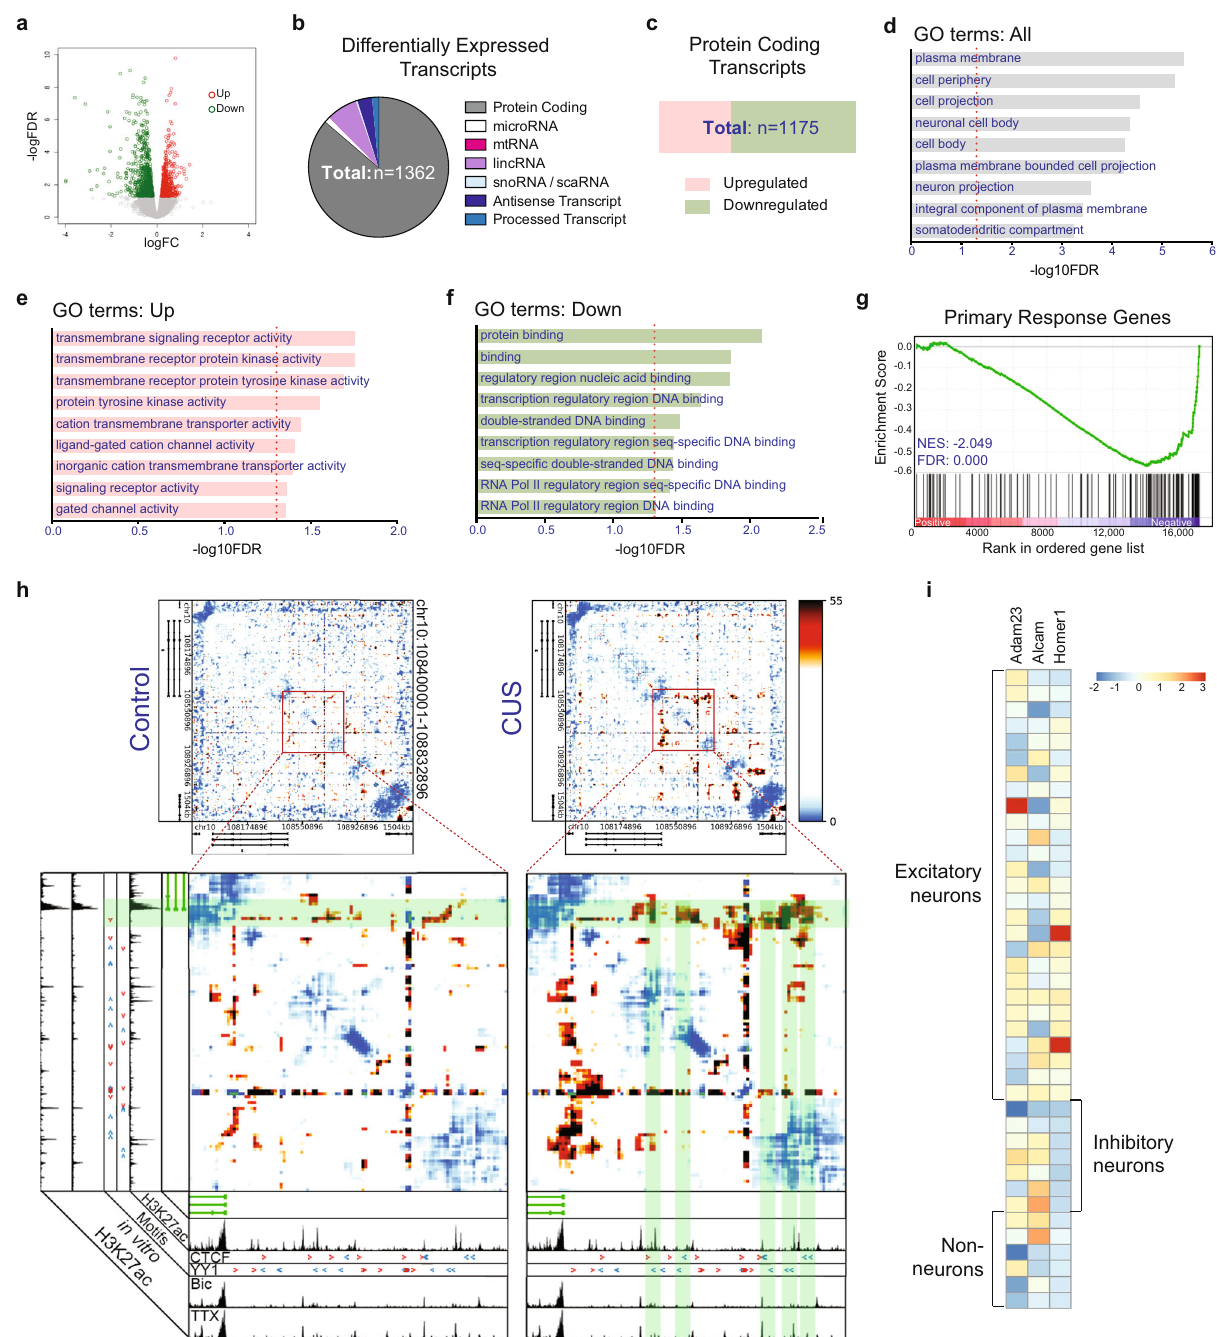
Fig. 2 CUS impacts transcription and chromatin folding in the PFC. a Signi fi cantly upregulated transcripts (red) and downregulated transcripts (green) from comparison of control and CUS PFC nuclear transcripts (FDR < 0.05). b Piechart exhibiting representation of differentially expressed RNA transcript populations. c Barchart portraying makeup of upregulated and downregulated differentially expressed protein-coding transcripts. d – f Top 9 most signi fi cantly enriched gene ontology (GO) terms for d all, e upregulated, and f downregulated CUS DEGs (FDR < 0.05). g GSEA plot charting negative enrichment of neuronal primary response genes in list of differentially expressed genes obtained from bulk nuclear RNA-seq analysis of control and CUS PFCs. NES, normalized enrichment score. h Background-corrected interaction frequency heatmaps displaying chromatin contacts in a 1.5-Mb region surrounding the Syt1 gene in control and CUS frontal cortical tissues. The highlighted region in each heatmap marks the location of a zoomed-in plot. H3K27ac ChIP-seq track from adult cortical excitatory neurons control is shown below each heatmap. Enlarged heatmaps plot genomic locations and directionality of CTCF and YY1 binding sequences (red and blue arrowheads) in regions showing increased chromatin interactions in CUS mice (green shaded boxes). Legend depicts background-corrected interaction scores. i Heatmap showing expression of CUS DEGs, Homer1, Adam23 , and Alcam , across the cortical cell populations de fi ned by single-nucleus RNA-seq in the adult mouse neocortex. Legend depicts z-score of normalized gene